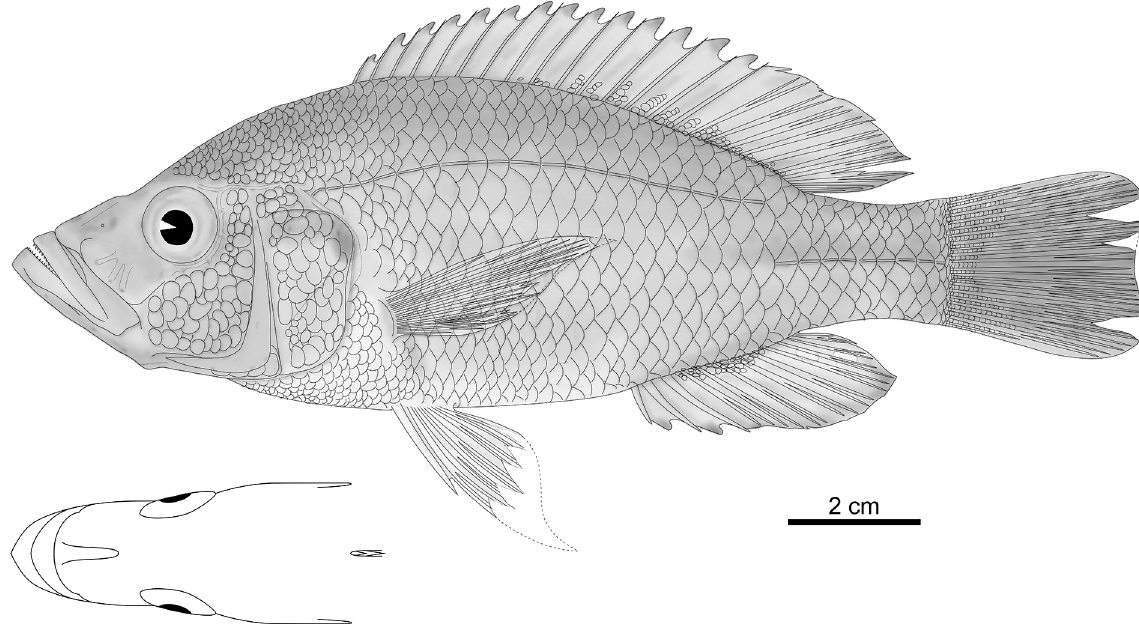
Fig. 38. Haplochromis squamipinnis Regan, 1921, holotype, ♀, 136.9 mm SL (NHMUK 1914.4.8.32). Drawn by N.